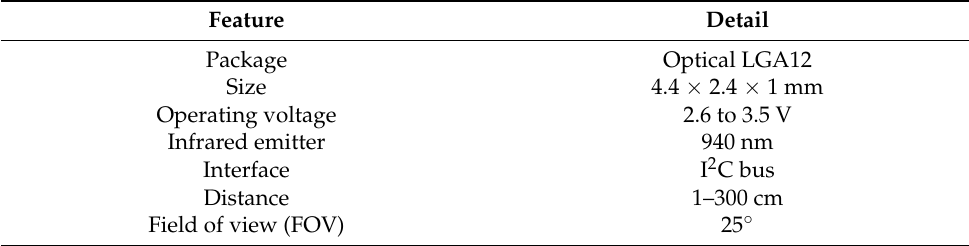
Table 1. Technical specifications of VL53L3CX